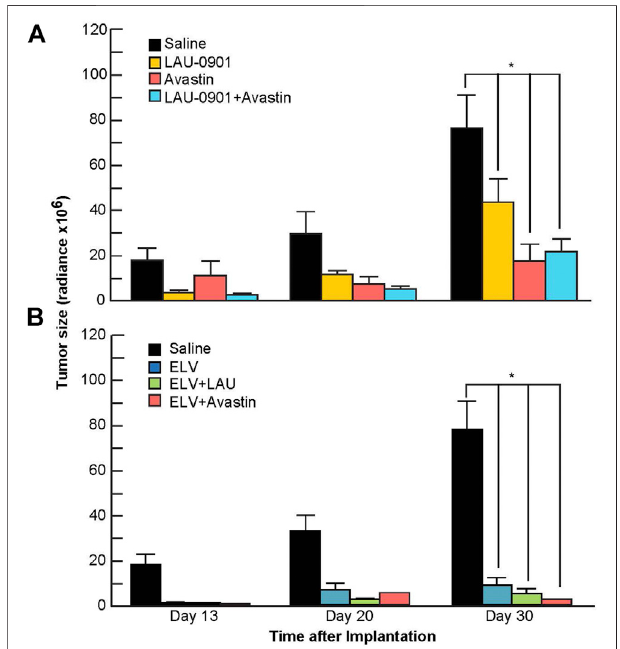
FIGURE5| Quanti fi cationofbioluminescentsignalsfromtumors.Radiance (Radiance × 10 6 ) values from regions of interest in mice from all groups were averagedandcomparedondays13,20,and30followingintracranialimplantation of U87-Luc cells. Tumor-bearing mice treated with (A) LAU-0901, Avastin, LAU-0901 + Avastin and (B) ELV, ELV + LAU-0901, and ELV + Avastin were observed have signi fi cantly reduced tumorigenesis when compared to vehicle- treated mice. All values are mean ± SEM ( n (cid:2) 5 – 7), * p <